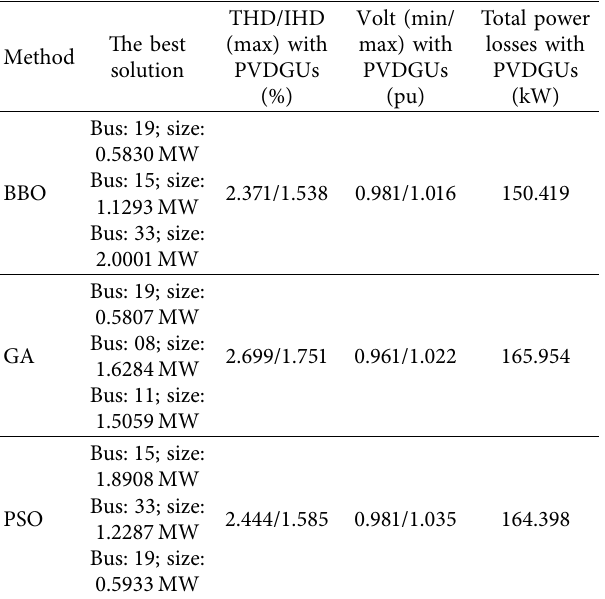
Figure 9: The fitness values of seven methods in 50 trial times for the fourth case. Table 11: The best solutions and the total capacity of PVDGUs found by nine implemented methods for the IEEE 33-bus distri- bution network in Case